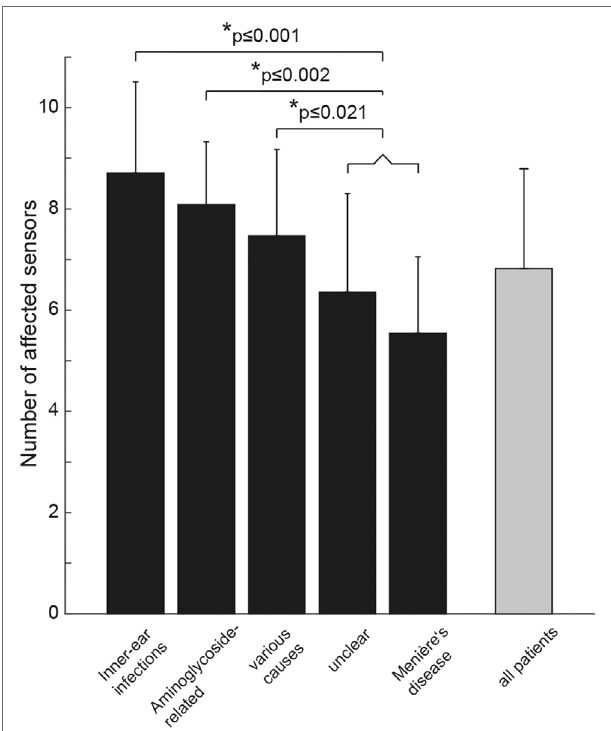
FigUre 5 | Bar plot illustrating the mean ( ± 1 SD) number of affected vestibular sensors (for each side: anterior/posterior/horizontal semicircular canal, utriculus, sacculus) separately for the different subgroups (in black) and for all patients pooled (in gray). “Various” includes patients with trauma ( n = 2), bilateral sensorineural hearing loss ( n = 3), bilateral schwannoma ( n = 4), combined schwannoma and vestibular neuropathy ( n = 1), cerebellar ataxia, neuropathy, vestibular areflexia syndrome ( n = 2), autoimmune ( n = 3), and central causes ( n = 2). Statistically significant differences (SPSS: generalized linear model) are indicated by an asterisk